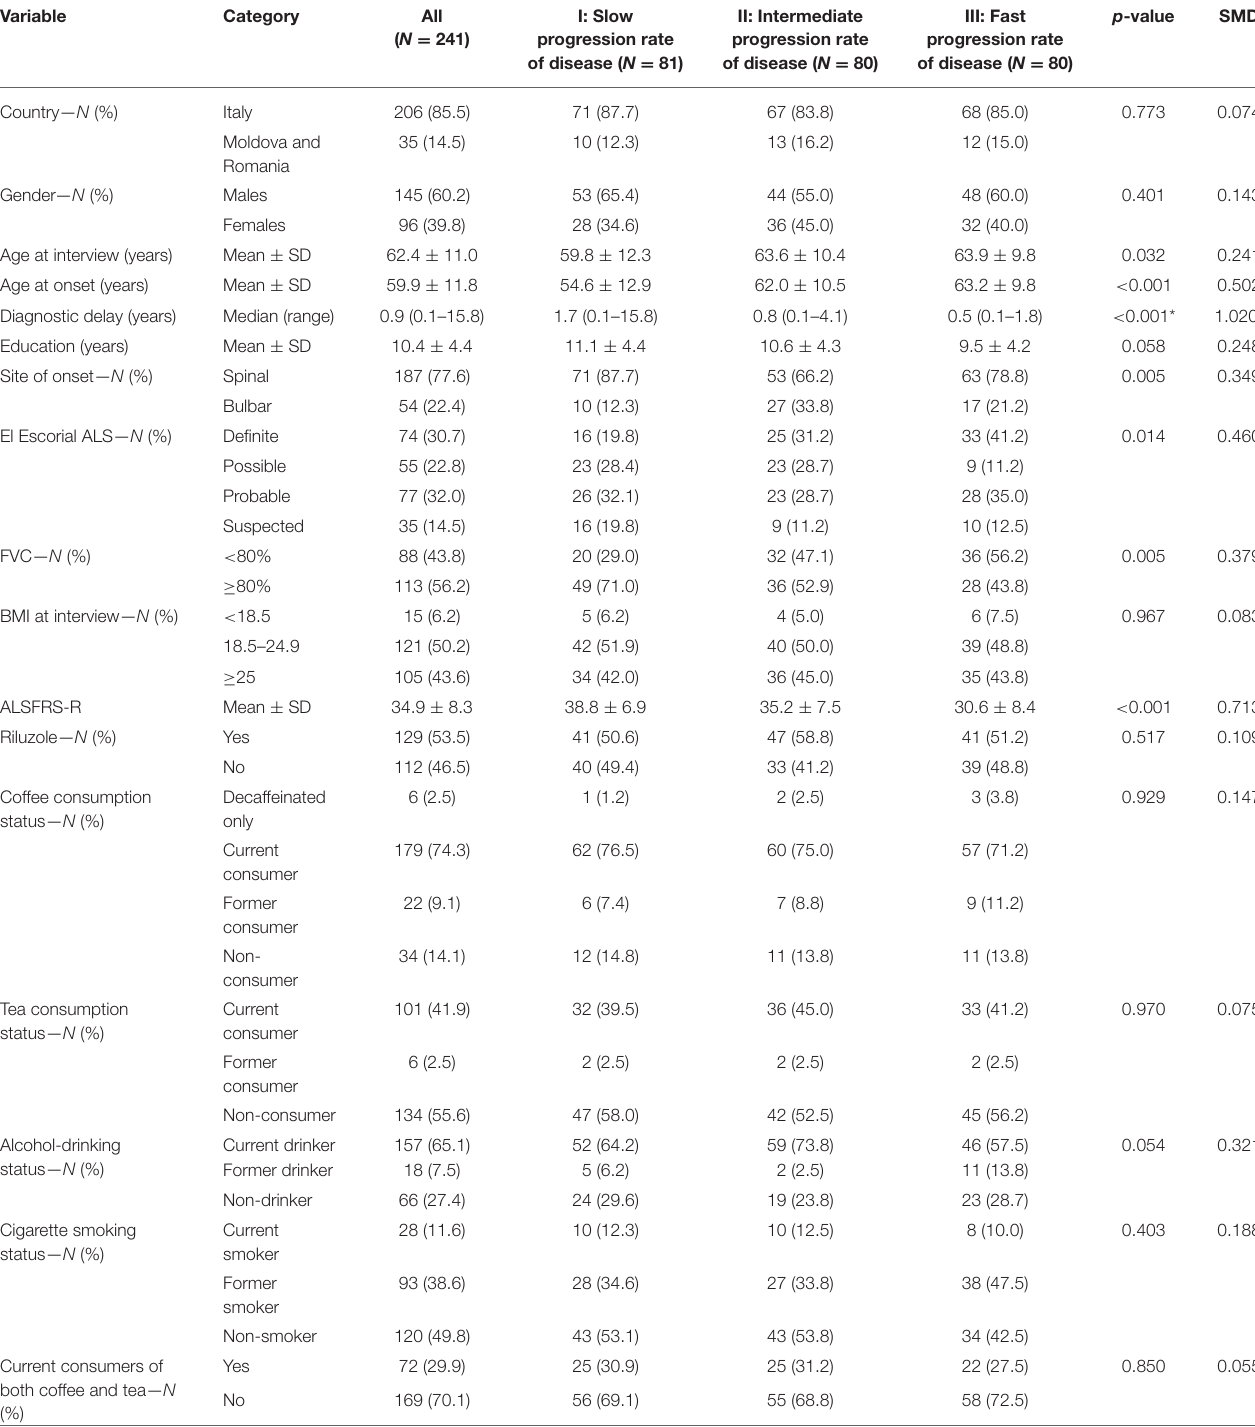
TABLE 1 | Clinical variables overall and according to the tertiles of 1 FS distribution.